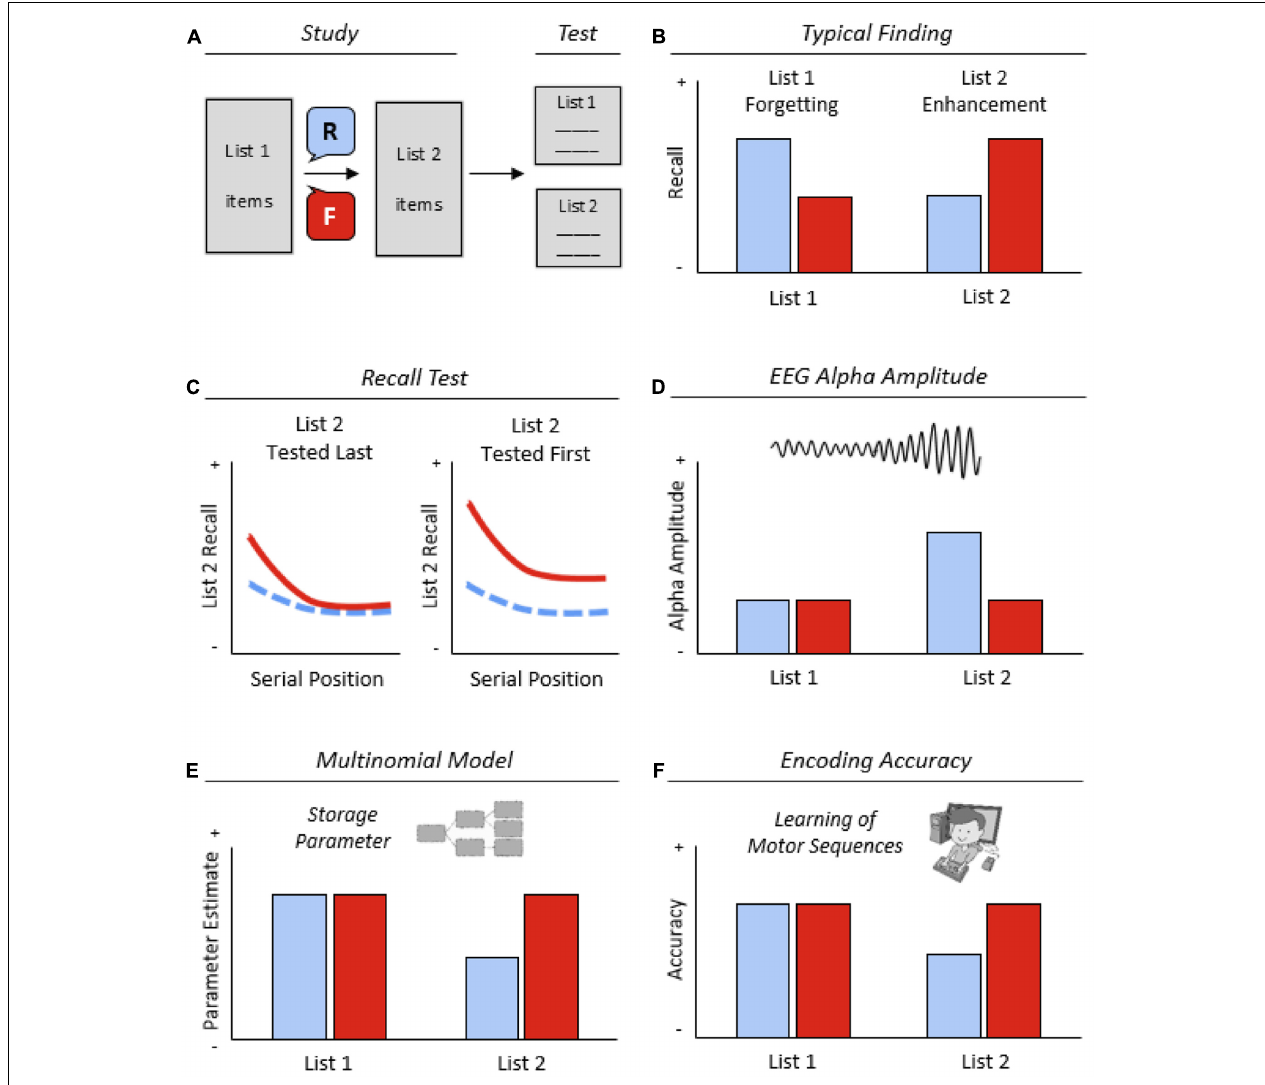
FIGURE 1 | (A) The list-method directed forgetting (LMDF) paradigm. Participants study two lists of items and, after the study of list 1 (L1), receive a cue either to forget (F) or continue remembering (R) this list before studying list 2 (L2). After study of L2, a memory test for both lists is conducted, in which participants are asked to recall the items of the two lists, irrespective of original cuing. (B) Typical finding. Compared with remember-cued participants, forget-cued participants typically show improved recall of L2 items and impaired recall of L1 items and, referred to as L2 enhancement (L2E) and L1 forgetting (L1F). (C) Serial position curves. When L1 is tested first and L2 is tested last, recall enhancement arises for the early L2 items only; when L2 is tested first, recall enhancement arises for all L2 items, although the early L2 items show a larger enhancement effect than the middle and late L2 items. F, solid line; R, dashed line. (D) Neurocognitive evidence for reset-of-encoding (ROE). EEG alpha amplitude during item encoding increases from L1 to L2 in the remember condition, but does not change in the forget condition. Low alpha amplitude indicates high encoding efficiency. (E) Model-based evidence for ROE. The estimate of the encoding parameter decreases from L1 to L2 in the remember condition, but does not change in the forget condition. (F) Behavioral evidence for ROE. In motor sequence learning, encoding accuracy decreases from L1 to L2 in the remember condition, but does not change in the forget